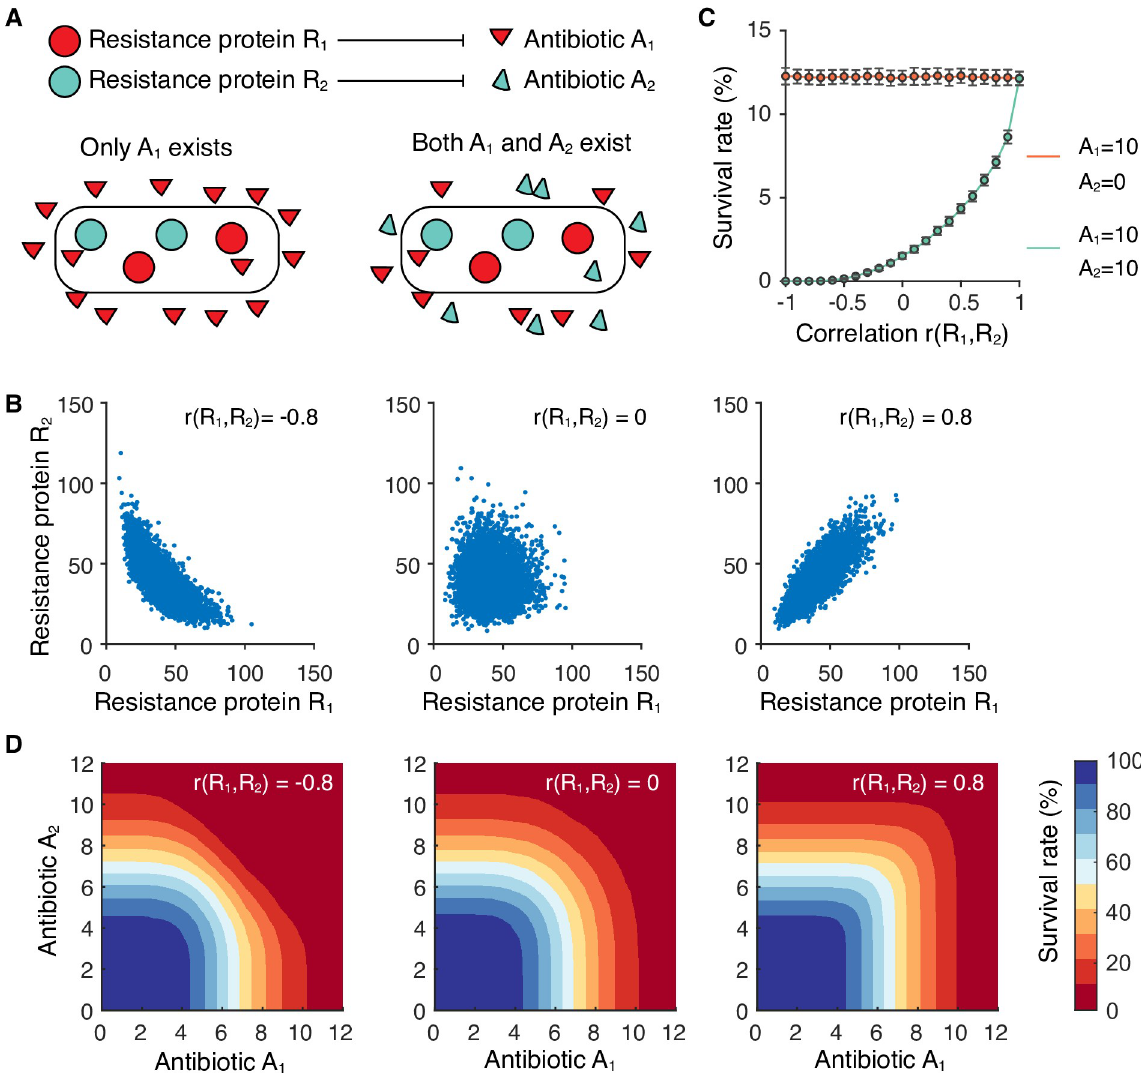
Fig 5. Correlated expression of resistance proteins in single cells facilitates population survival under multiple antibiotics. (A) An antibiotic resistance model. Two hypothetical antibiotics, A 1 and A 2 , are independently deactivated by two resistance proteins, R 1 and R 2 , respectively. Population survival rates are simulated in the presence of both A 1 and A 2 . (B) Simulated joint distribution of R 1 and R 2 at three different scenarios: negative correlation with r(R 1 ,R 2 ) = -0.8, uncorrelated with r(R 1 ,R 2 ) = 0, and positive correlation with r(R 1 ,R 2 ) = 0.8. (C) The dependence of population survival rate on the correlation between R 1 and R 2 . Error bars represent standard deviations of 100 simulations. (D) Survival rate profiles at three simulated correlations as in B .